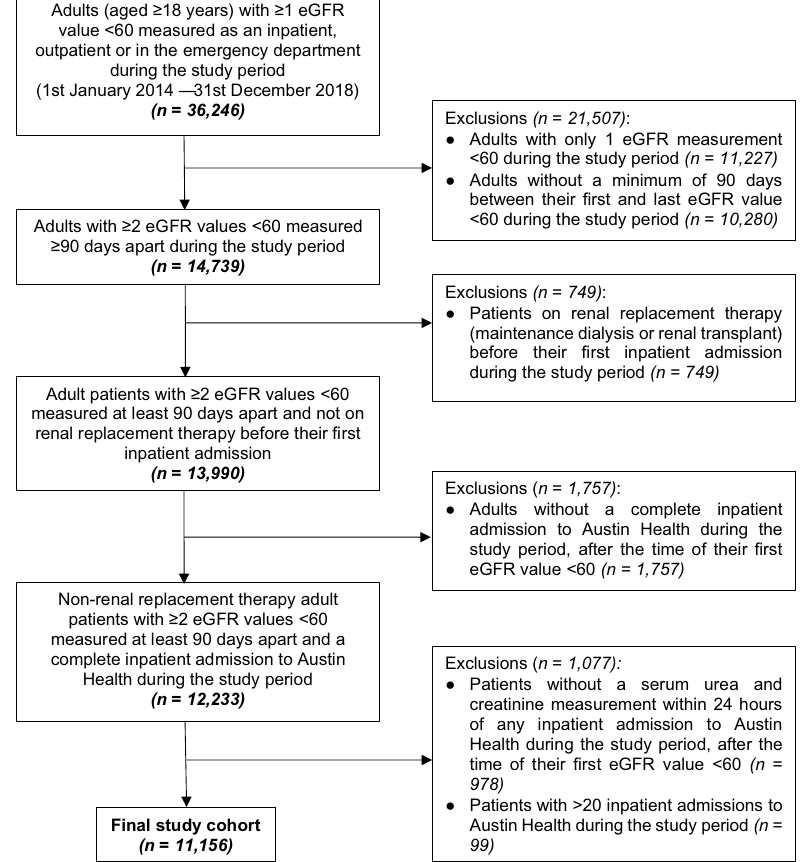
Figure 1. Patient selection for the study cohort. The study cohort included adult patients (aged ≥ 18 years) with at least two abnormal eGFR values (< 60 mL/min/1.73m 2 ) measured greater than 90-days apart between 1st January 2014 and 31st December 2018 in inpatient, outpatient or emergency department settings. Adult patients were included if they had a serum urea and creatinine tests performed within 24-h of any inpatient admission to Austin Health following their first abnormal eGFR result. Patients with end-stage kidney disease, defined as maintenance dialysis (both haemodialysis and peritoneal dialysis) or renal transplant, were excluded from the time of the procedure. Patients with greater than 20 inpatient admissions were also excluded. Abbreviations: eGFR, estimated Glomerular Filtration Rate measured in mL/min/1.73m 2